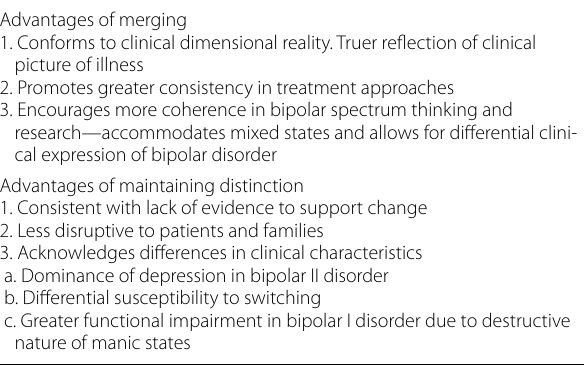
Table 1 Advantages of merging bipolar I and II disorder